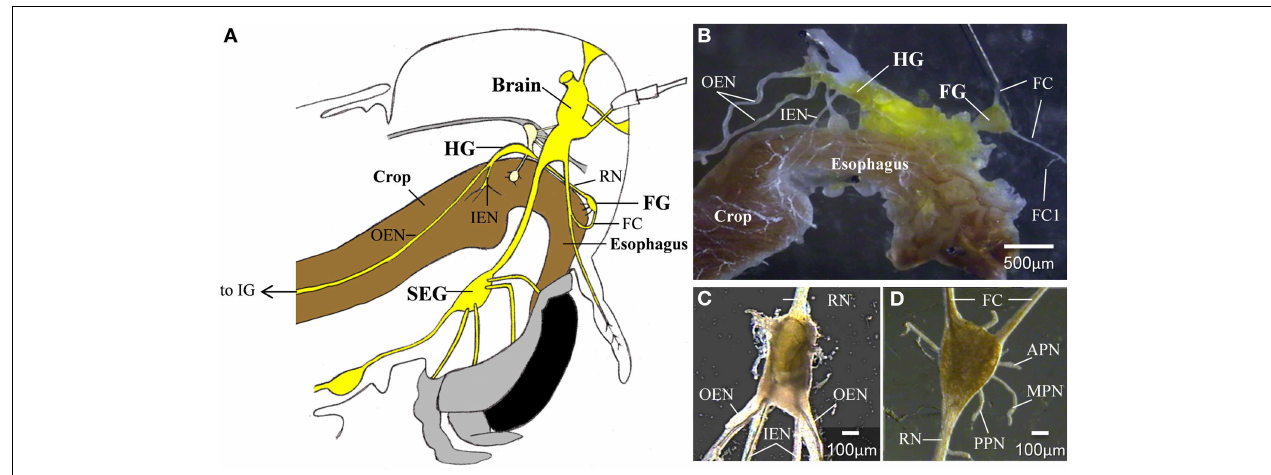
frontal connective 1; FG, frontal ganglion; HG, hypocerebral ganglion; IEN, inner esophageal nerve; IG, ingluvial ganglion; MPN, median pharyngeal nerve; OEN, outer esophageal nerve; PPN, posterior pharyngeal nerve; RN, recurrent nerve; SEG, subesophageal